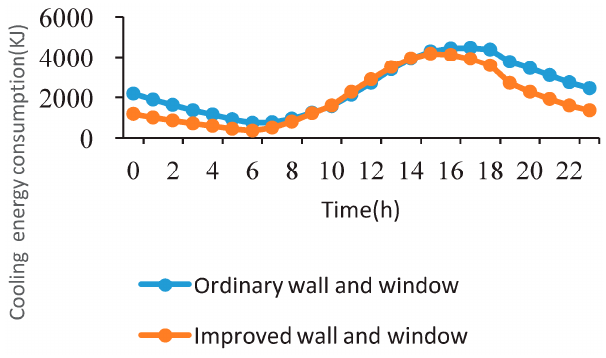
Figure 9. Energy consumption comparison of different walls.